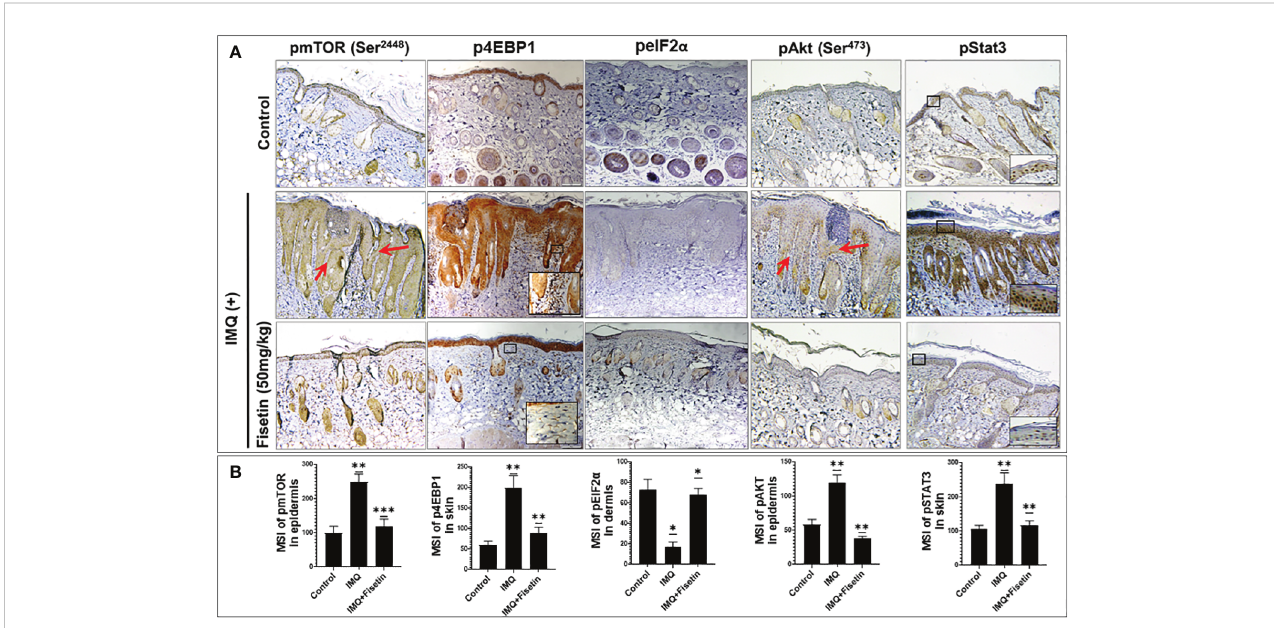
FIGURE 6 Fisetin inhibits the phosphorylation of mTOR, 4EBP1, Akt and Stat3 and increased the phosphorylation of eIF2 a in IMQ-treated skin of mice. (A) Immunohistochemical staining of p-mTOR (Ser 2448 ), p-4EBP1(Thr 37/46 ), p-eIF2 a (Ser 51 ), p-Akt (Ser 473 ) and p-Stat3 (Tyr 705 ), in fi setin- or vehicle-treated in IMQ-induced mouse dorsal skin sections. Scale bar = 100 µm. (B) Quanti fi ed intensity of p-mTOR, p-4EBP1 and p-eIF2 a , p-Akt and p-Stat3 per 20× microscopic fi eld view. The mean intensities and quanti fi cations are shown in bar graphs as mean ± SE, and paired t test was used to compare values between the different treatments. These were calculated from each group (n=6). *P <0.05; **P <0.01 and ***P <0.001 . (-) indicates control